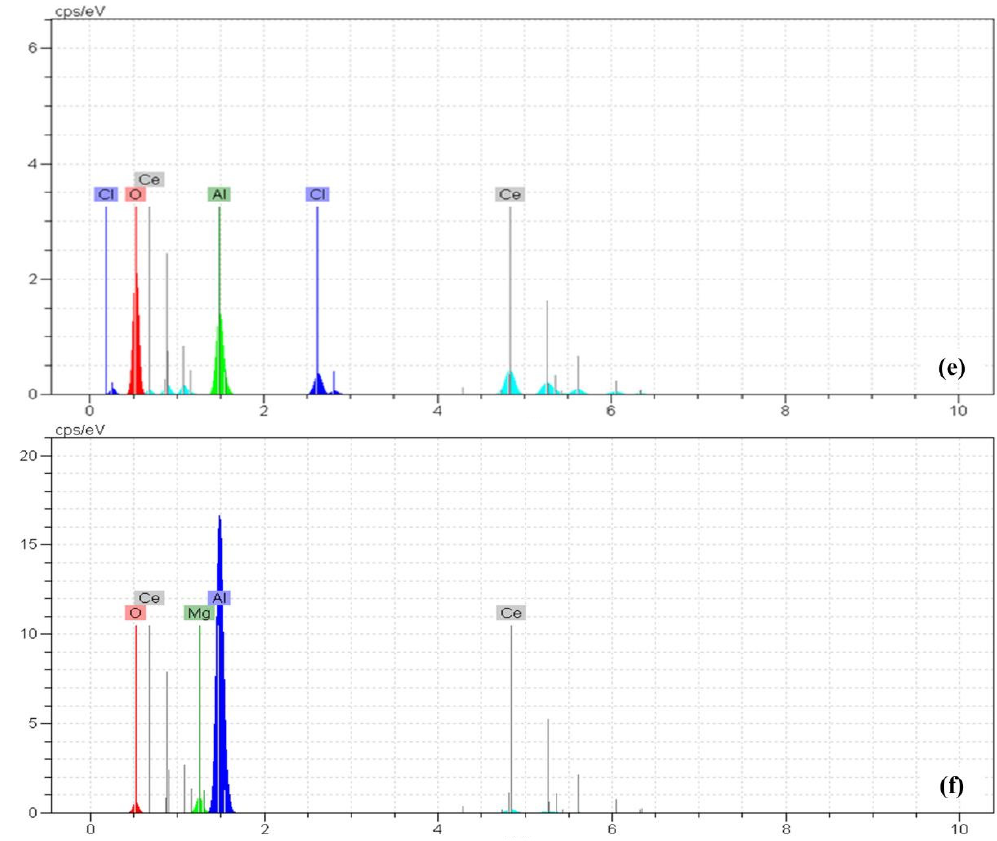
Figure 7. EDS analysis of different cerium coated and uncoated AA5083 prepared by different pretreatments ( a ) uncoated AA5083,